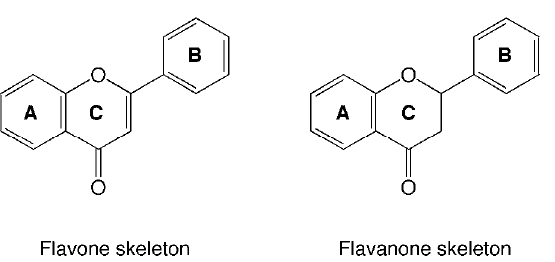
Figure 1 . Flavone and flavanone skeletons.